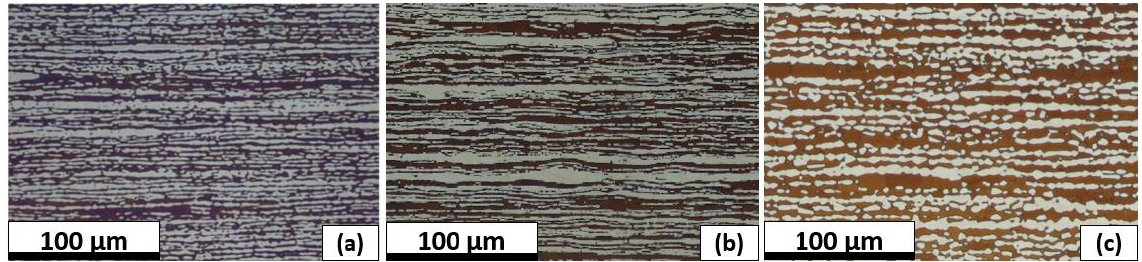
Figure 4. Industrial ( a ) and modified annealed ( b ) 1100 °C — 0 s and ( c ) 1180 °C — 300 s microstructures where ferrite grains appear in dark and austenite ones in light.